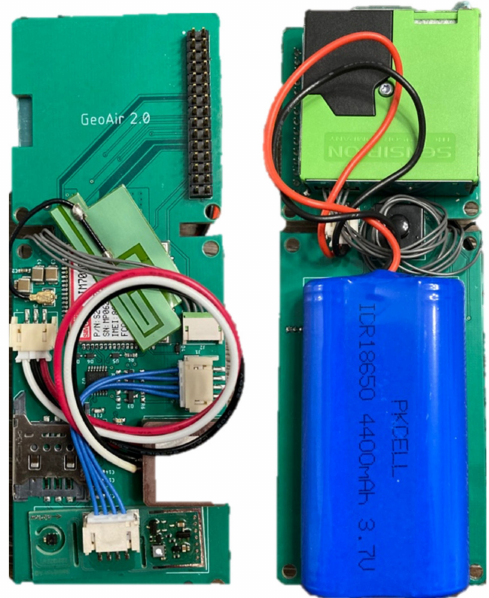
Figure 1. A printed circuit board (front and back) of GeoAir.